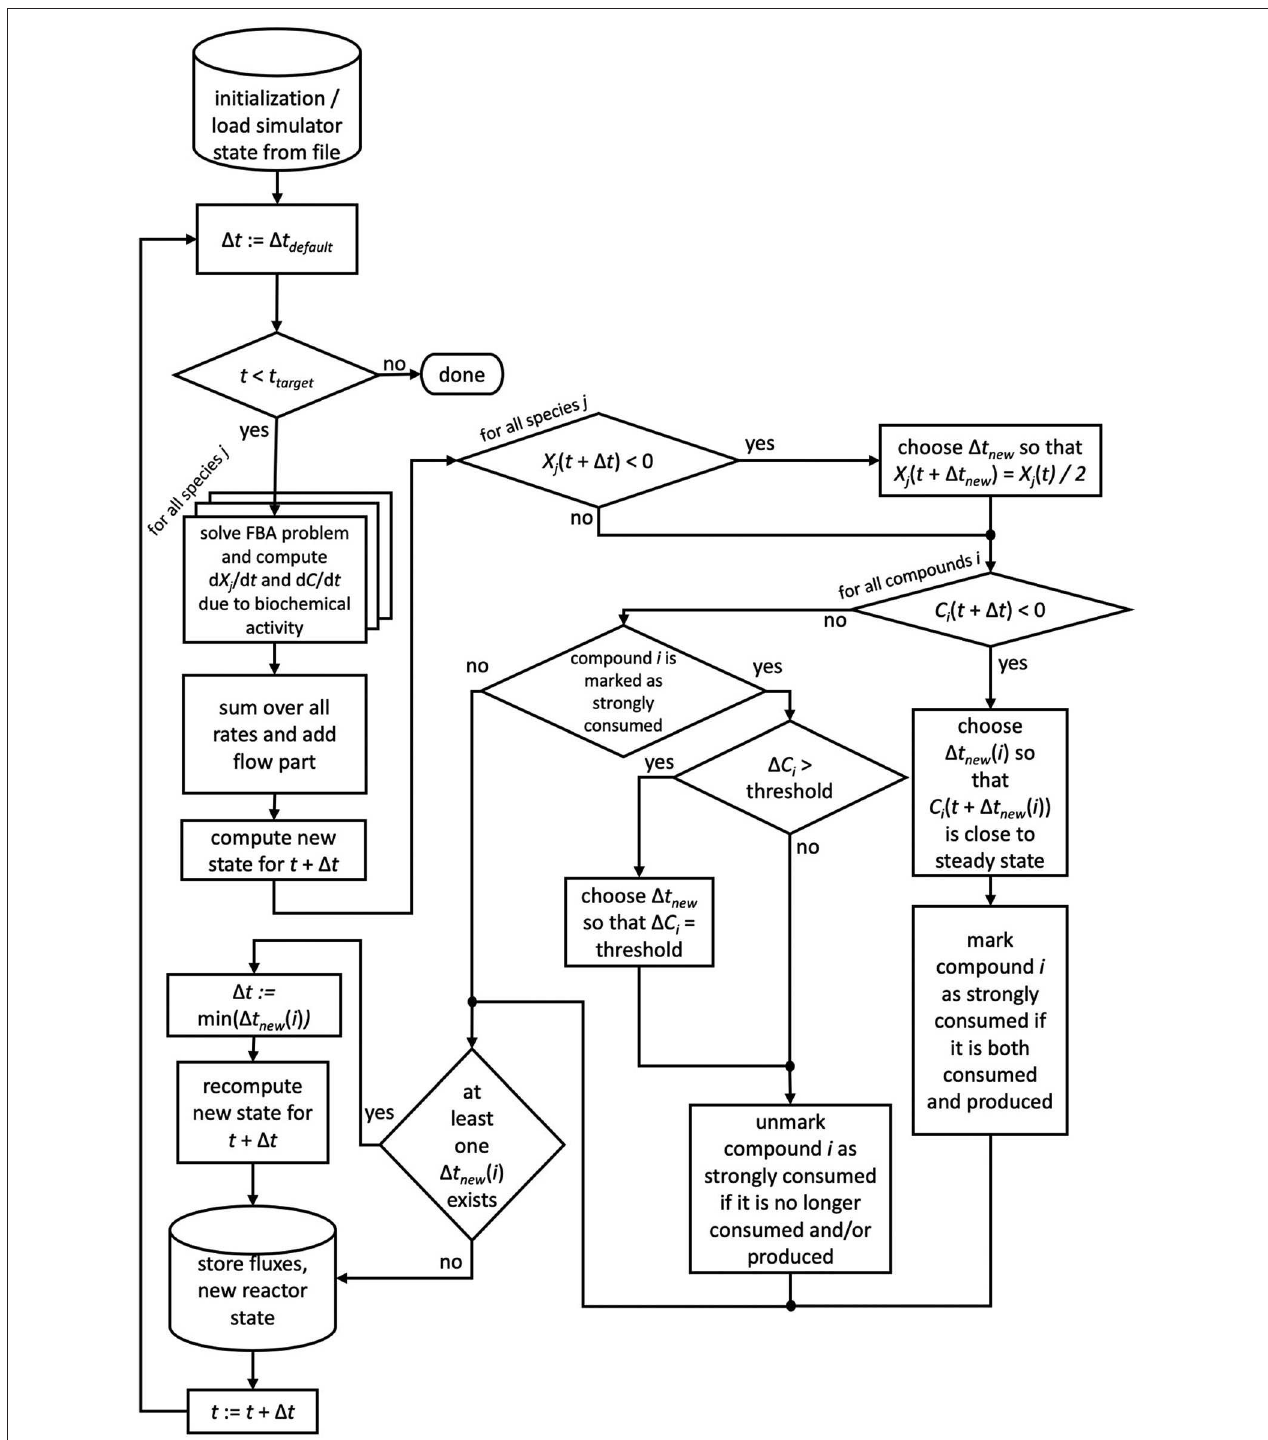
FIGURE 1 | The augmented forward Euler scheme implemented in µ bialSim. In each numerical integration step, first the FBA solutions are computed for all member species of the simulated microbiome. The new system state is then computed using obtained rates and the default time step size. If negative concentration values for biomasses or compounds occur, the time step size is reduced as required.